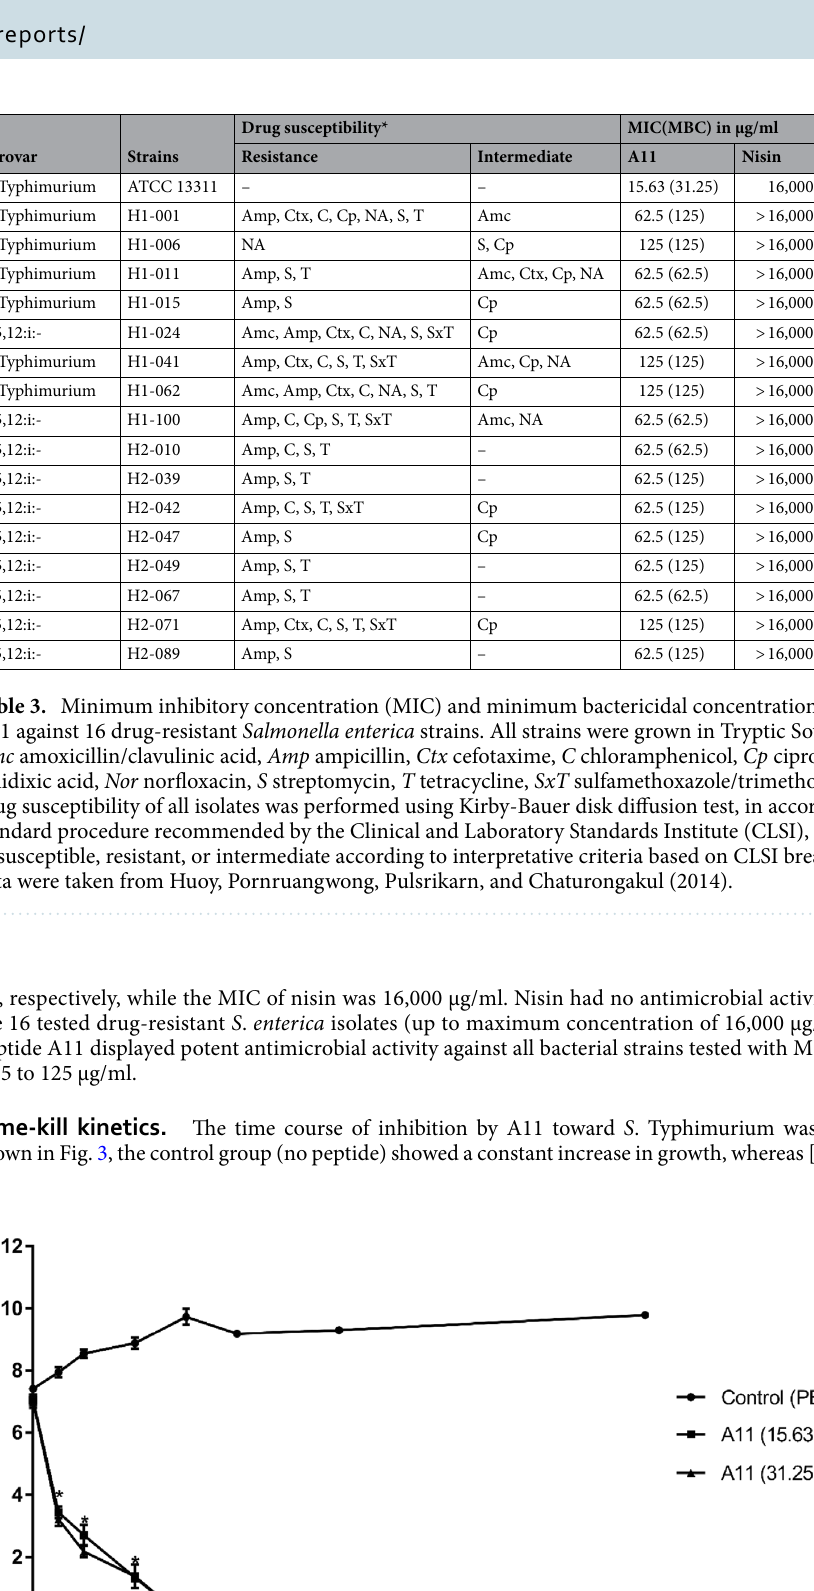
Figure 3. Effect of A11 peptide at MIC and MBC concentrations on the time-kill curve of S . Typhimurium ATCC 13311 for 0, 1, 2, 4, 6, 8, 12 and 24 h. The experiments were done in triplicate and the data are represented as the mean ± SD. The statistical analysis was performed using two-way ANOVA and Tukey’s test (p < 0.05). An asterisk (*) indicates a statistically significant difference when compared to that of control